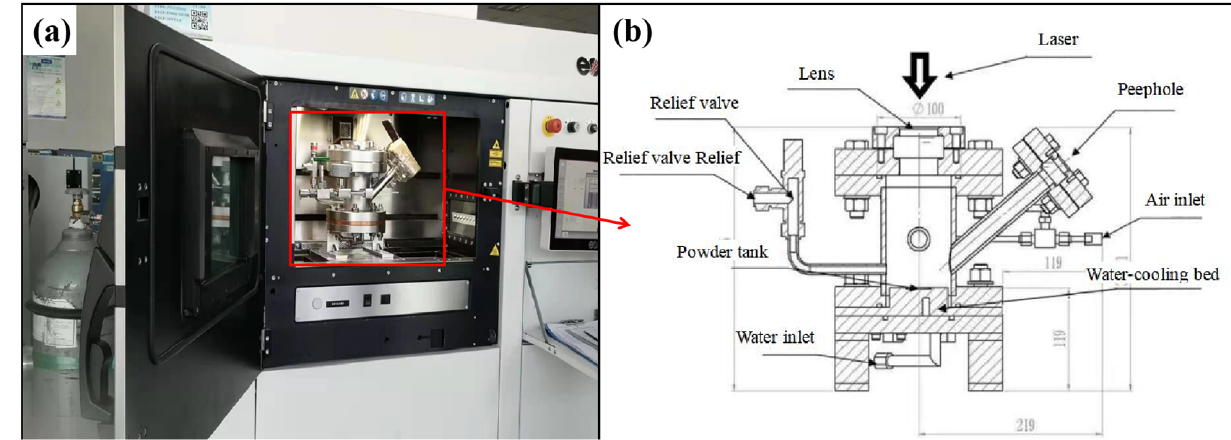
Figure 2. High-pressure melting chamber: ( a ) overall view of the SLM equipment; ( b ) profile view of high-pressure melting chamber.